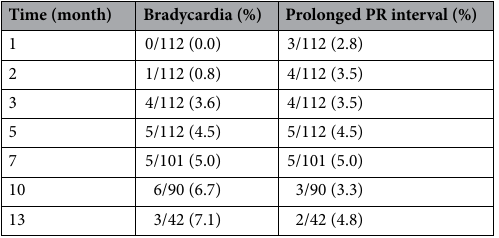
Table 2. Incidence of bradycardia and PR interval